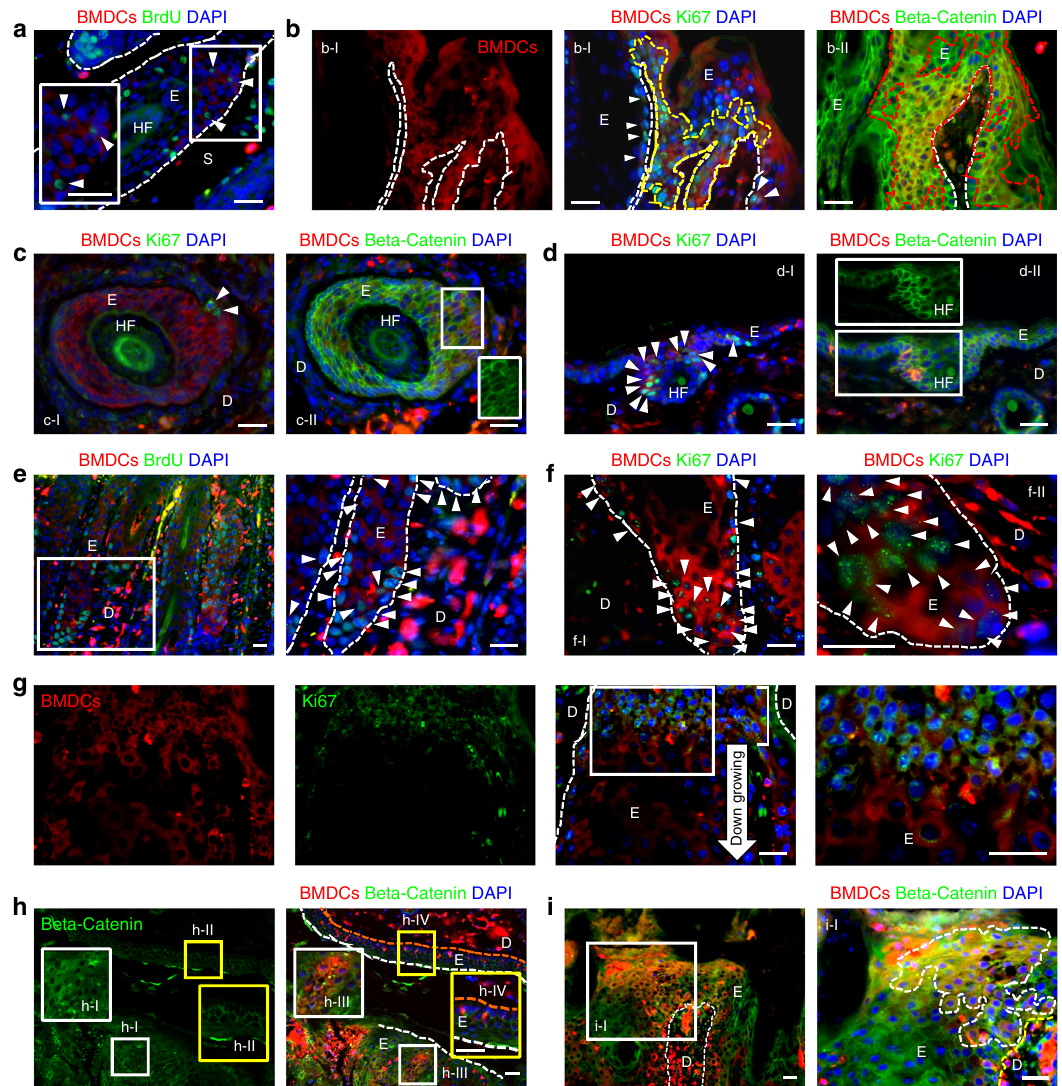
Fig. 5 BMDECs in the papillomas and dysplasia are proliferating. a BrdU-positive BMDECs (arrowheads, white box area is magni fi ed) are identi fi ed in the outer root sheath area of a deregulated HF under the tumor mass. b BMDECs in epithelium of papilloma (a serial section of Fig. 3a). b-I A group of Ki67- expressing BMDECs (area of yellow broken line and arrowheads) are identi fi ed in the basal epithelium of the papilloma. b-II Cytoplasmic beta-catenin expression was detected from BMDECs (areas of red broken line) in the epithelium of the papilloma. c BMDECs in deregulated HF structure under the tumor mass (a serial section of Fig. 3i). c-I Few Ki67-positive BMDCs (arrowheads) were identi fi ed in the section and c-II BMDCs in this area show membrane beta-catenin expression (GFP-channel in white box shows membrane expression). d BMDECs in tumor-adjacent hyperplastic epidermis (a serial section of Fig. 3f). d-I Ki67-expressing BMDCs (arrowheads) are located in HF and d-II strong membrane beta-catenin expression is detected overall in the epidermis, but low levels of cytoplasmic beta-catenin expression are detected in BMDCs in the HF (GFP-channel in white box). e – i BMDECs in dysplastic skin. e BrdU-positive BMDCs (arrowheads) are identi fi ed in the basal region of dysplastic epithelium. White box area is magni fi ed. f f-I Ki67- expressing BMDCs (arrowheads) are identi fi ed in the basal region of dysplastic epithelium. f-II Higher magni fi cation micrograph from different dysplastic skin sample. g Small Ki67-expressing BMDCs (white box area is magni fi ed) are detected in the neck region (white line, located at junction between down- growing deregulated HF and interfollicular epidermis). h KCs and BMDCs in dysplastic epidermis (white boxes, magni fi ed in h-I and h-III) show cytoplasmic show membrane expression. i BMDCs in dysplasia (white box area and area of white broken line in i-I) show cytoplasmic beta-catenin expression.